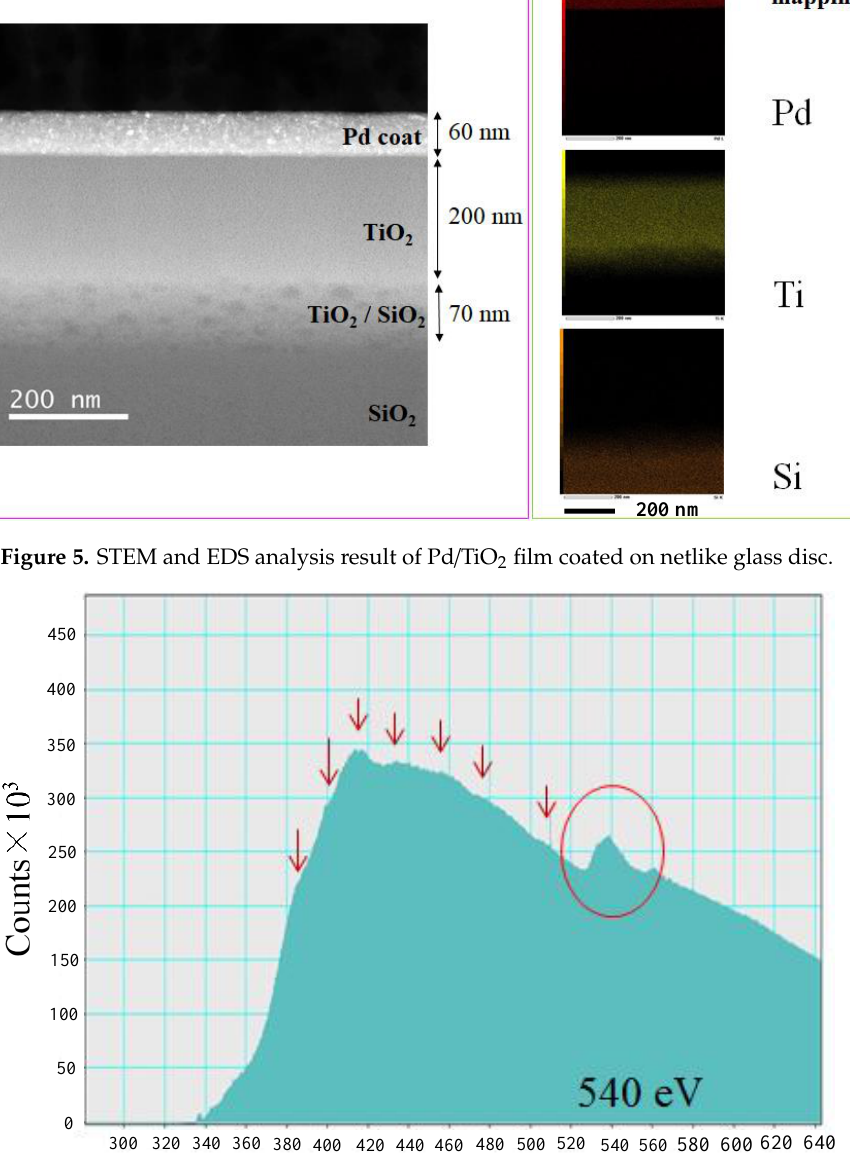
Figure 6. EELS spectra of Pd in Pd/TiO 2 .